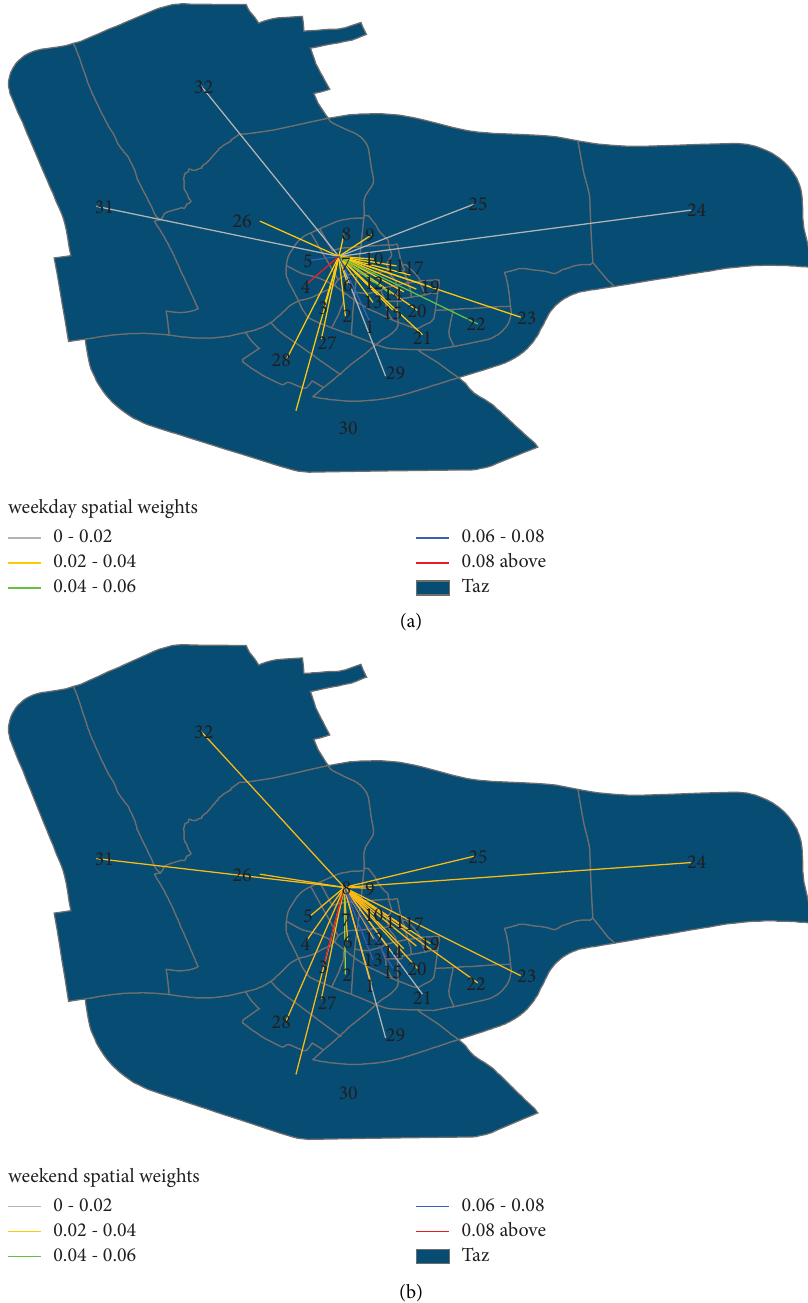
Figure 13: Spatial distributions of weight elements for typical TAZs in weekday and weekend. (a) Spatial distribution of weight elements for TAZ 7 in weekday. (b) Spatial distribution of weight elements for TAZ 8 in